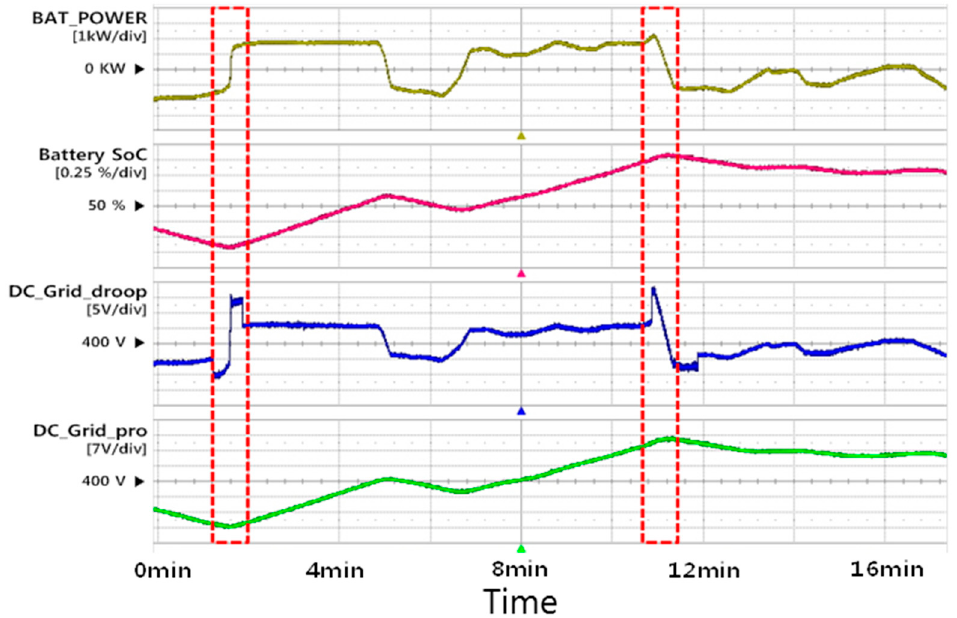
Figure 14. Comparison of experiment results by the existing droop control and the proposed control.